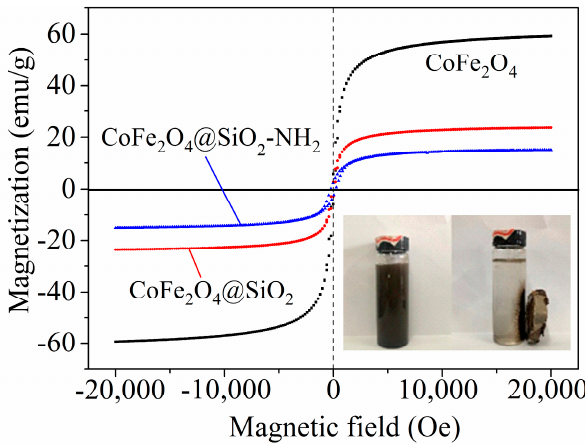
Figure 5. VSM of CoFe 2 O 4 , CoFe 2 O 4 @SiO 2 and CoFe 2 O 4 @SiO 2 -NH 2 MNPs.